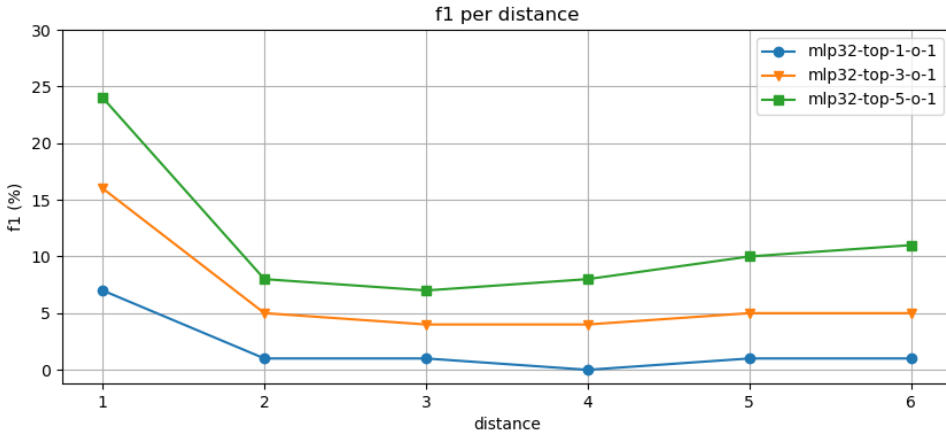
Figure 8. F1 of top-N